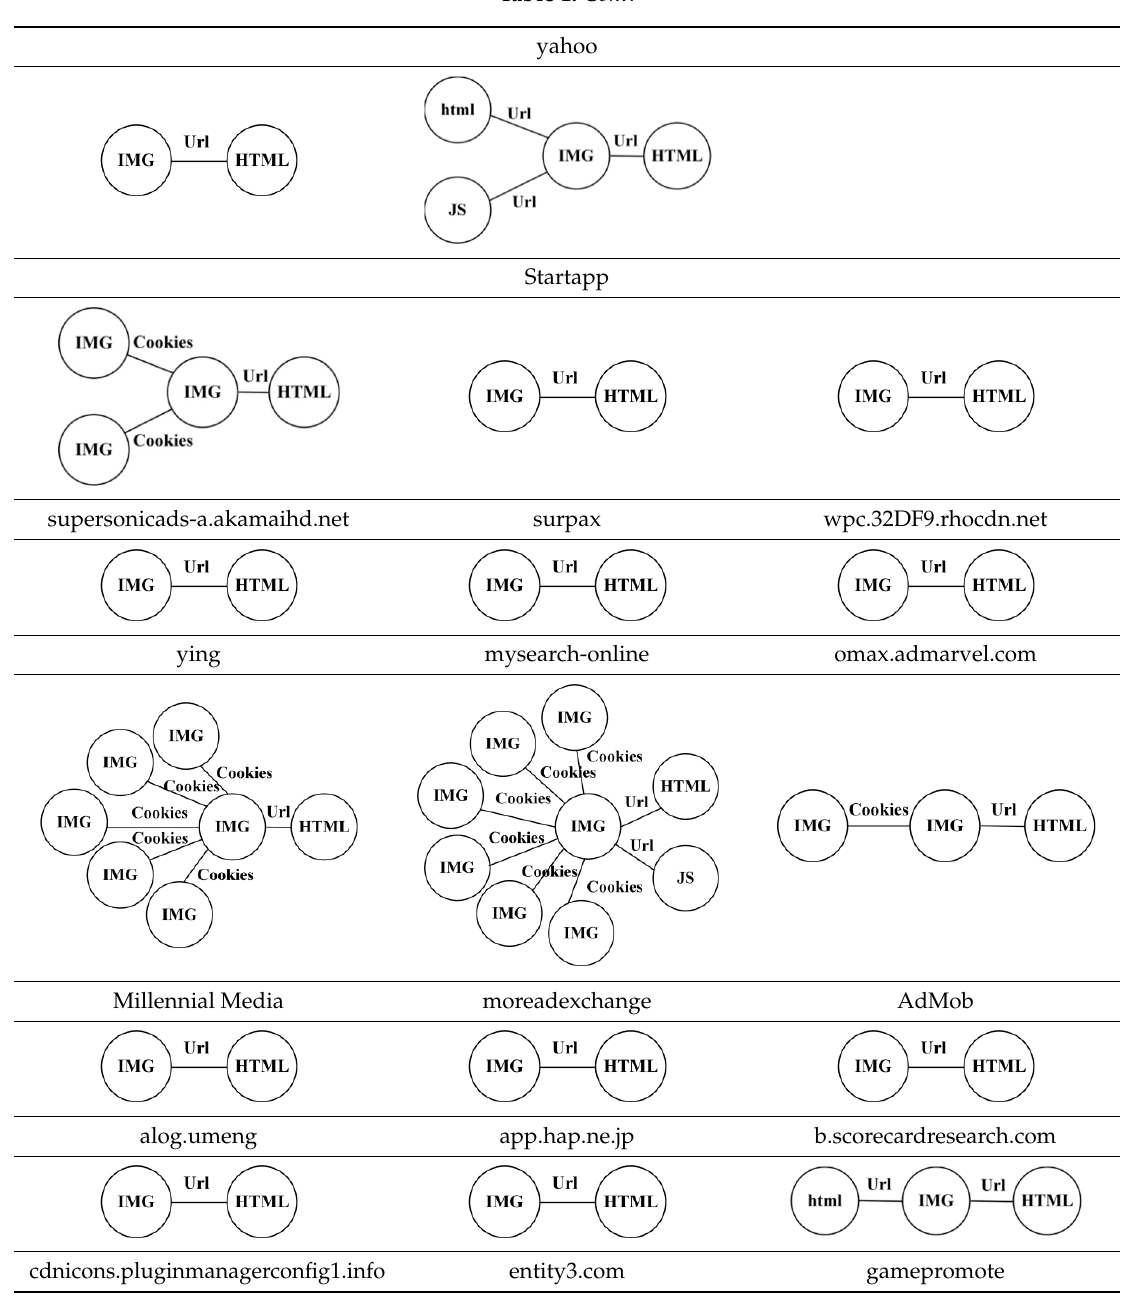
Table 2. Graph types and their corresponding ad libs (with graph as index).